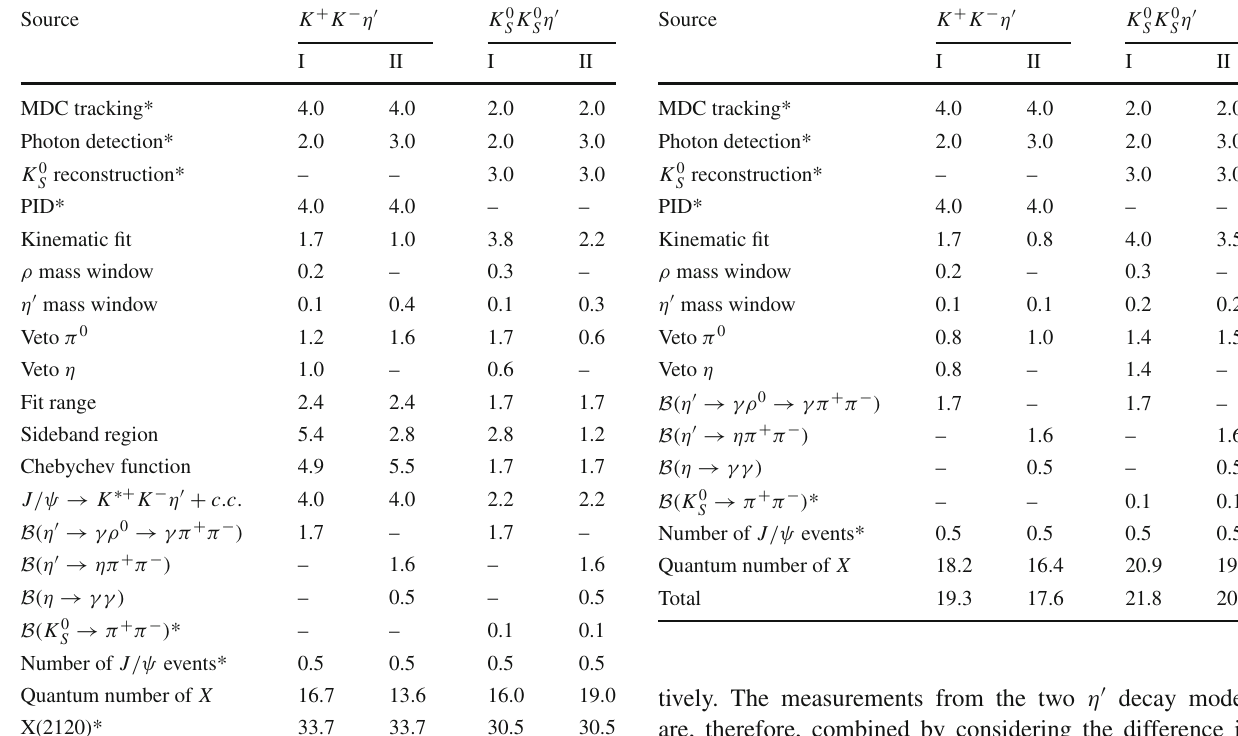
Table 5 Systematic uncertainties for the determination of the upper limit of the branching fraction of J /ψ → γ X ( 2120 ) → γ K ¯ K η (cid:3) (in %). The items with * are common uncertainties of both η (cid:3) decay